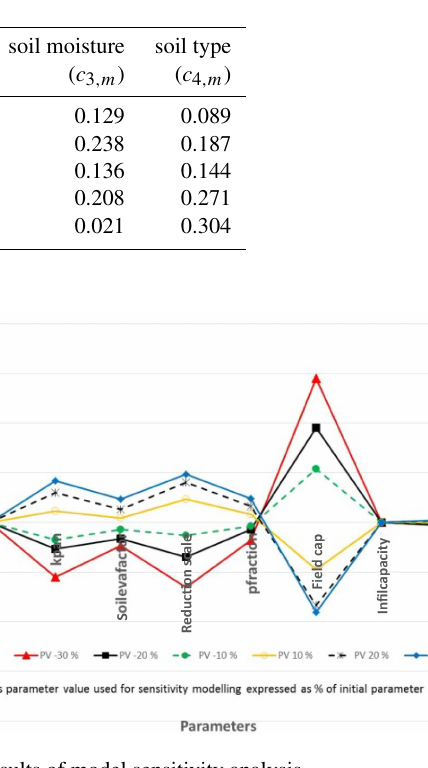
Figure 3. Results of model sensitivity